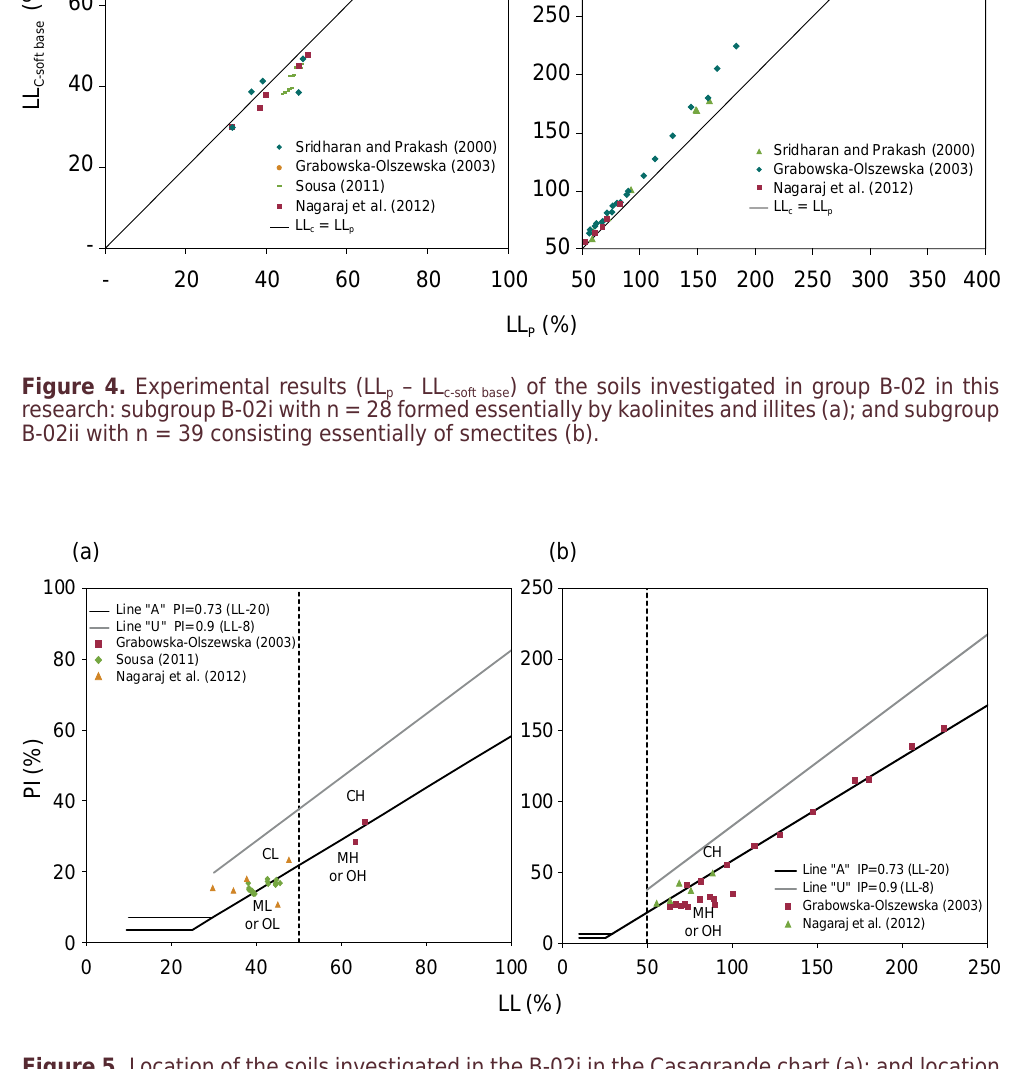
Figure 5. Location of the soils investigated in the B-02i in the Casagrande chart (a); and location of the soils investigated in B-02ii in the Casagrande chart